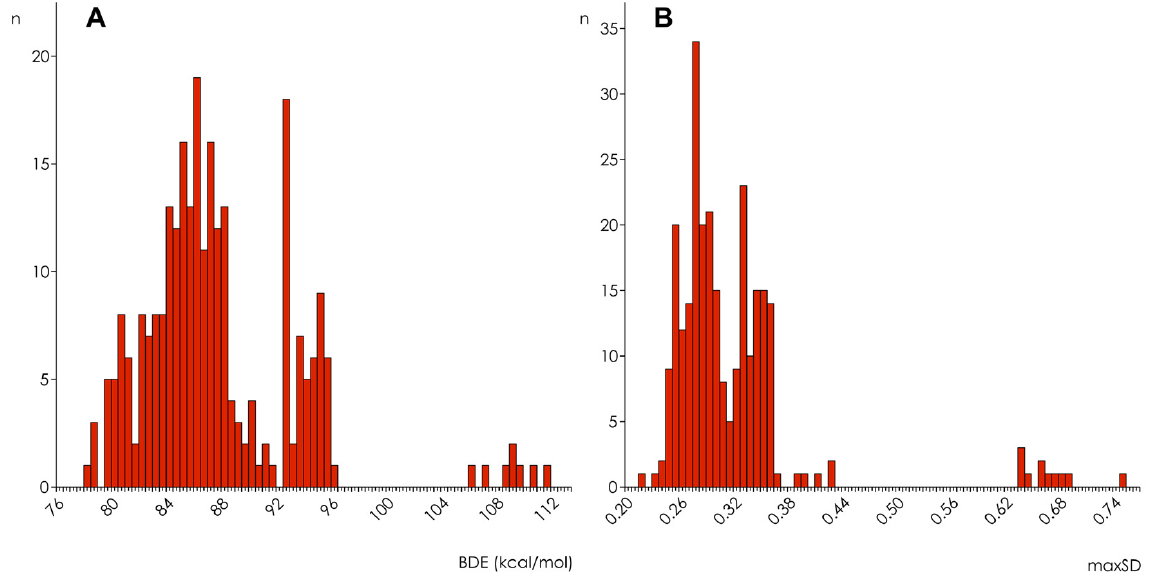
Figure 1. Distribution histograms for BDE ( A ) and maxSD ( B ) obtained in semi-empirical simulations using AM1 Hamiltonian without COSMO corrections ( n = 265).